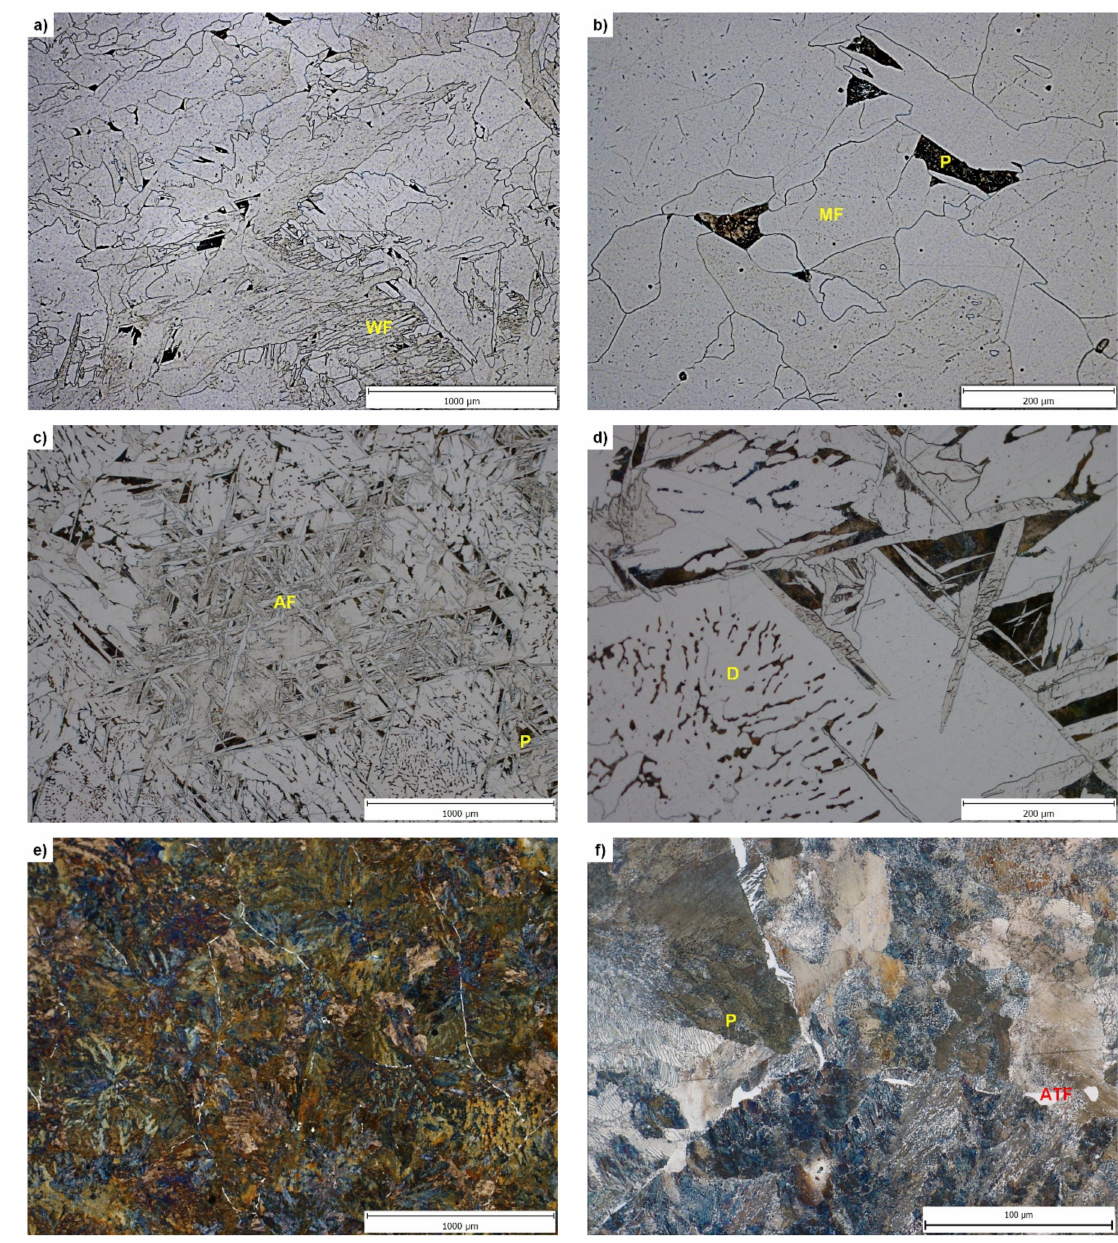
Figure 2. Initial structure of investigated steels A, B and D (dendrites—D, acicular ferrite—AF, allotri- omorphic ferrite—ATF, massive ferrite—MF, Widmanstatten ferrite—WF, pearlite—P): ( a , b ) steel A; ( c , d ) steel B; ( e , f ) steel